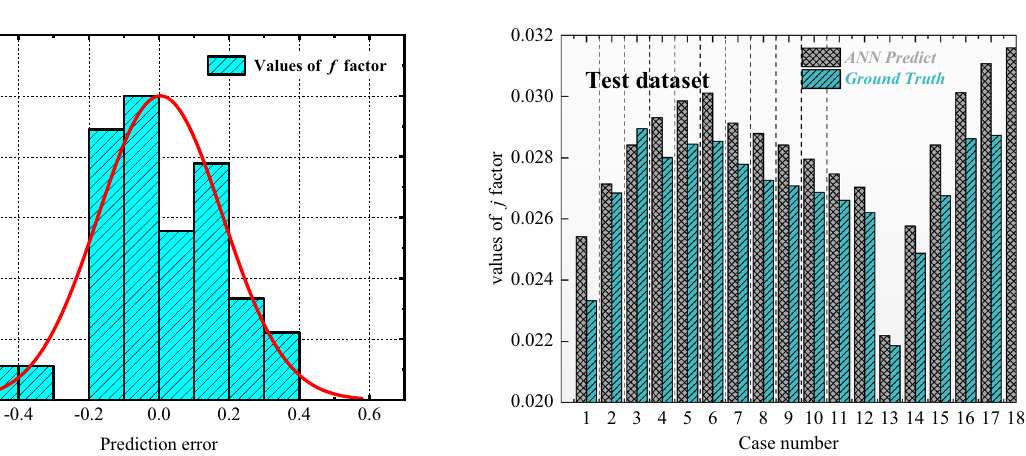
Figure 12 Comparison of predicted and actual values of the j